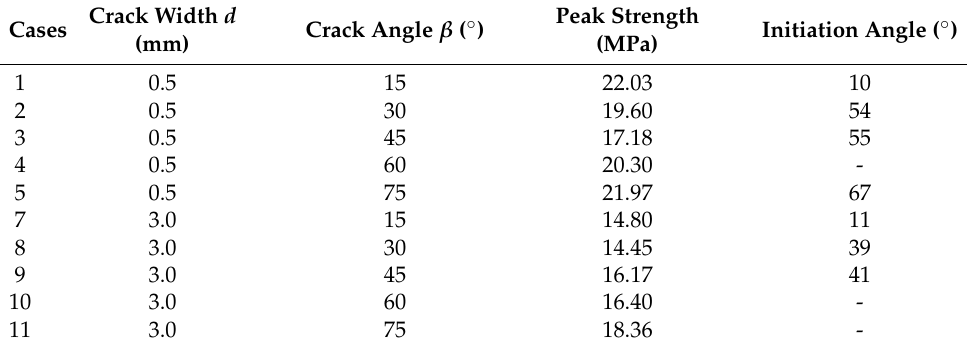
Table 3. Peak strength and crack initiation angle in uniaxial compression tests.